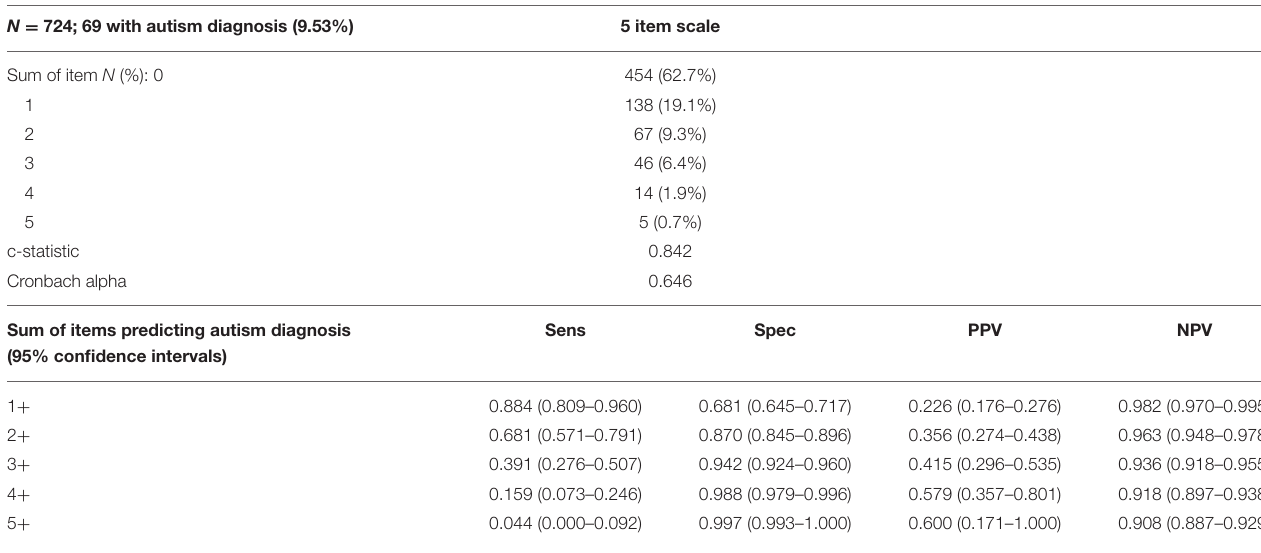
TABLE 3 | Five-item scale in trial population (age 3 and